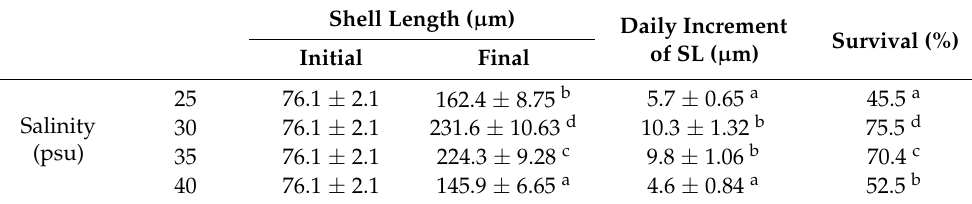
Table 2. The growth rate, daily increment of shell length SL and the survival rate of Mactra chinensis reared at different salinities for 15 days.